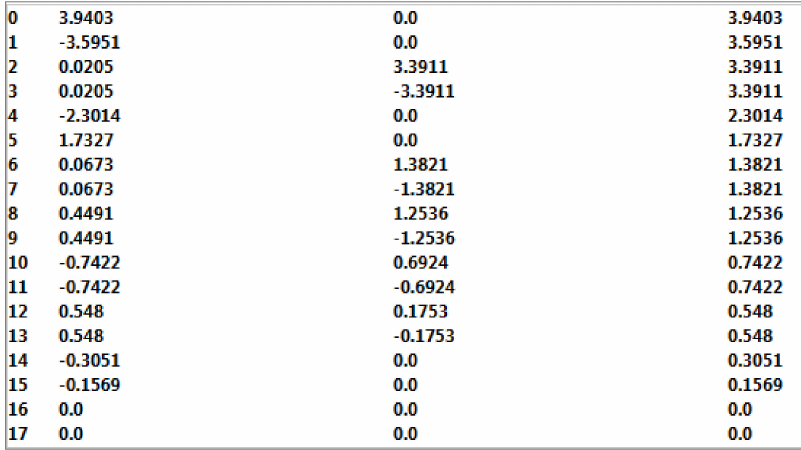
Figure 6. Eigenvalues of the adjacency matrix of the cognitive model G of the relationship between the regional system and the higher education system, taking into account the needs of the region (fragment from the computer data processing results on the program